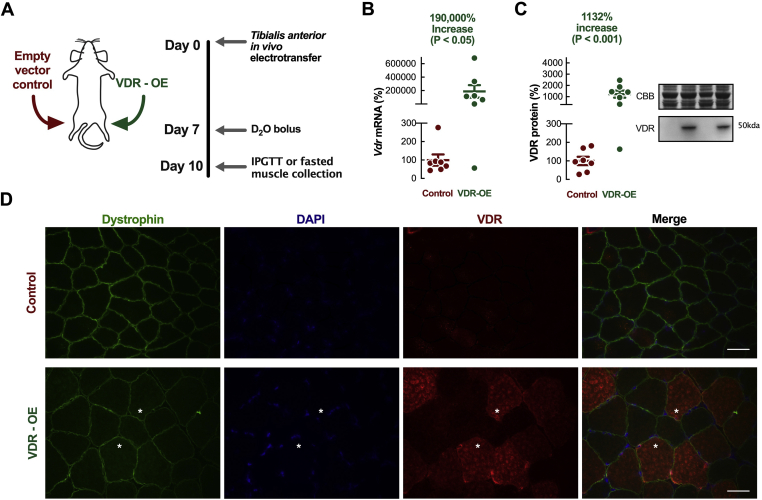
In vivo experimental design and grouping. (A) Schematic design of in vivo paired contralateral experiments. (B) Confirmation of contralateral VDR-OE by qRT-PCR (n = 7). (C) Representative western blot and quantification of VDR-OE (=7n). (D) Representative images of muscle fibres stained for dystrophin (green), DAPI (blue) and VDR (red). Scale bars represent 200 μm. Data are mean ± SEM. Significance indicated measured by paired t-test. (For interpretation of the references to color in this figure legend, the reader is referred to the Web version of this article.)